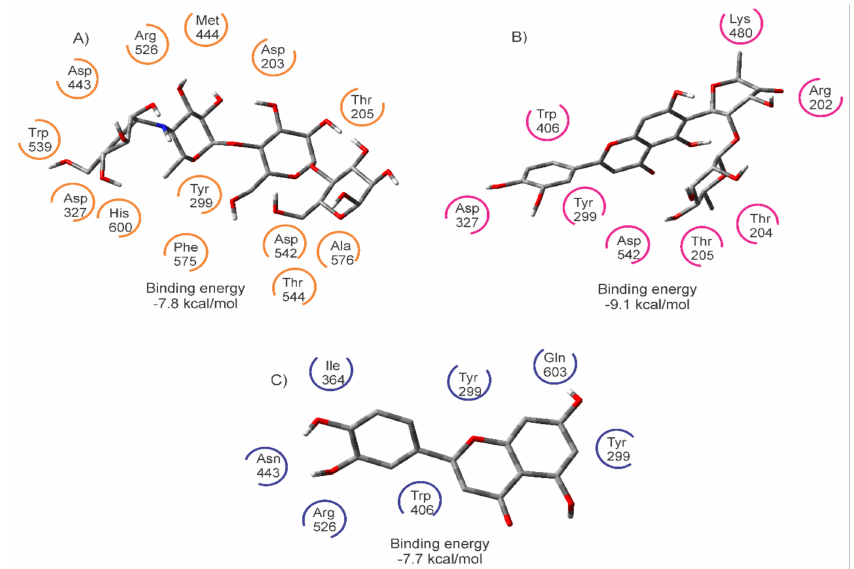
Figure 4. Amino acids of the active site of the maltase-glucoamylase (NtMGAM), with ( A ) acarbose (ACA), ( B ) maysin (MAY), and ( C ) luteolin (LUT), and the calculated binding energy values.